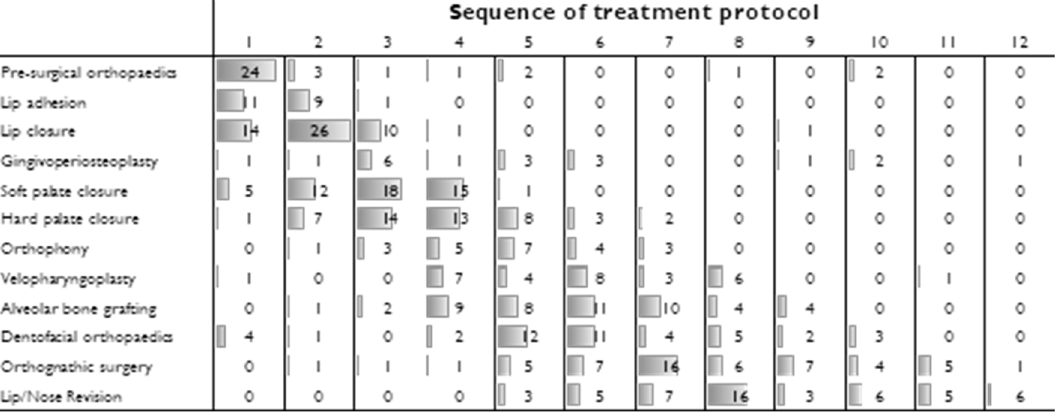
Figure 3. Sequence of treatment protocol. The numbers in the columns represent the responses given per procedure in chronological order.